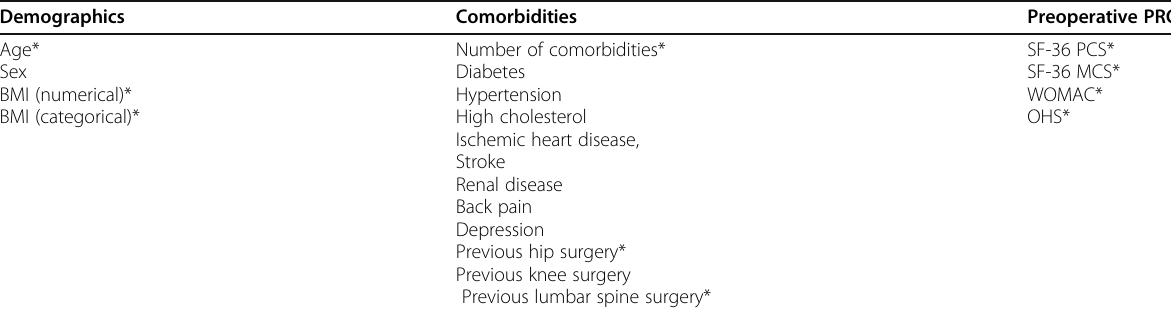
Table 1 Input variables for ML models